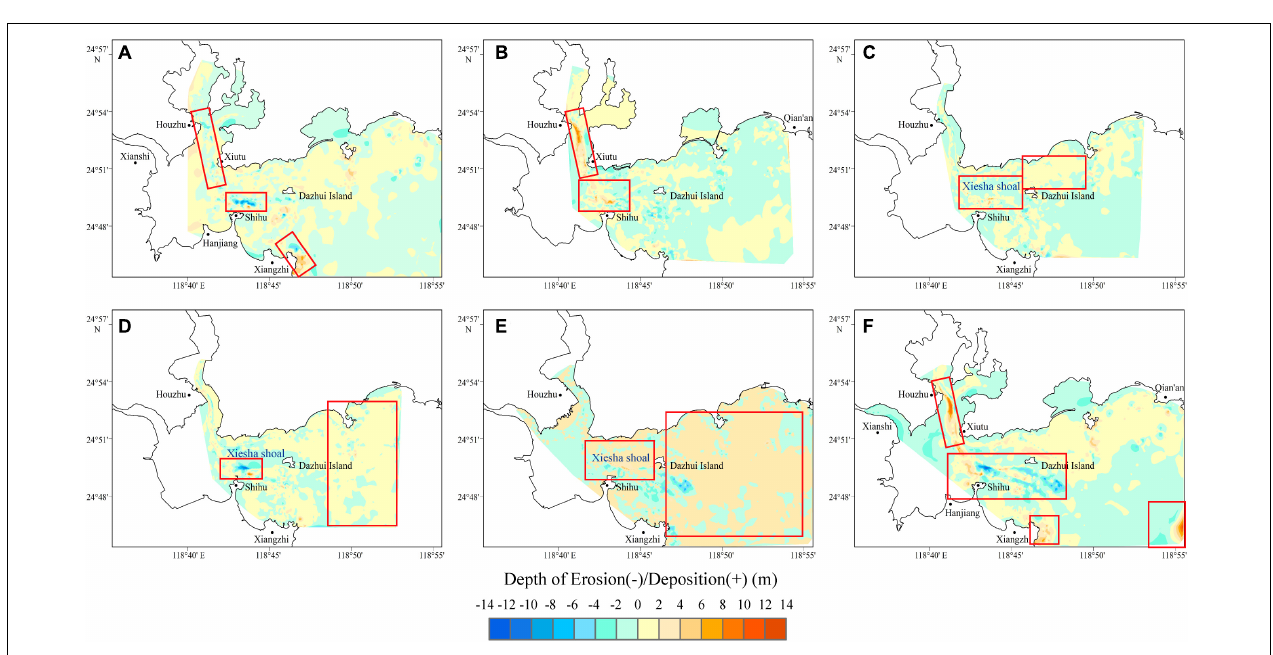
FIGURE 3 | Variation of isobath in Quanzhou Bay from 1954 to 2017. (A) 1954; (B) 1954–1988; (C) 1988–2017; (D) position of characteristic section. The arrows indicate changes in the isobath.